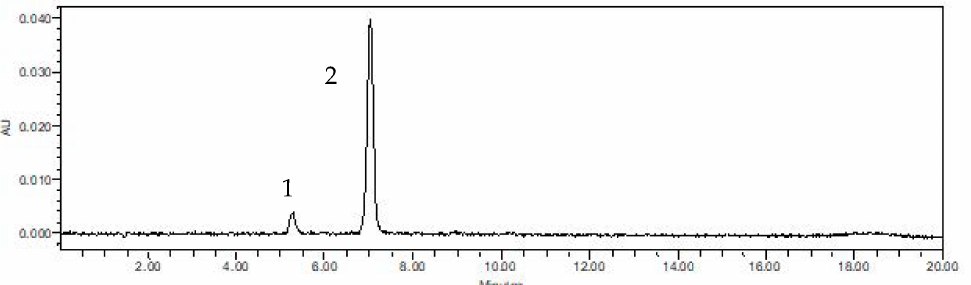
Figure 6. Monomeric anthocyanin chromatogram of jaboticaba extract by UAE, at 520 nm, where peak 1 is delphinidin-3-O-glucoside and peak 2 is cyanidin-3-O-glucoside.